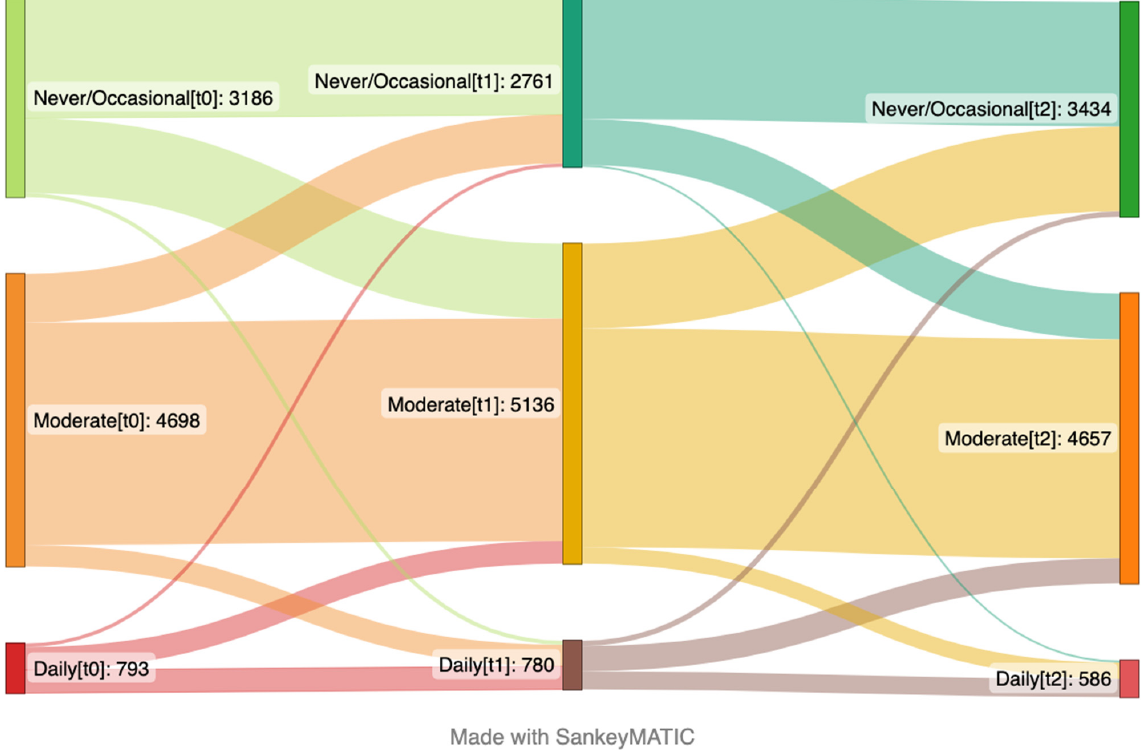
Figure 2. Sankey plot presenting changes in intake of high-sugar food and drinks over time from the April 2020 (left side) to January 2021 (center) and May 2022 (right side). The number in brackets represents time points. This plot includes the participants that answered the items focusing on intake of high-sugar food and drinks on the questionnaire at the first time point (t 0 ), second time point (t 1 ) and third time point (t 2 ) (n = 8677).